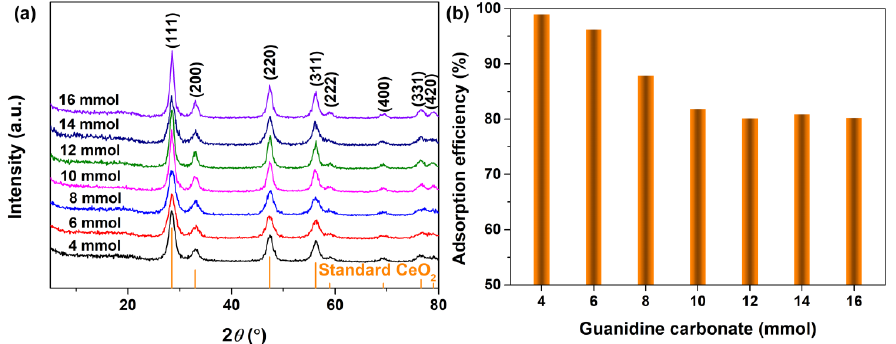
Figure 2. ( a ) XRD patterns of the hydrothermally synthesized CeO 2 samples at 180 °C for 24 h with different addition amounts of guanidine carbonate (4~16 mmol) and 5 mL 30% H 2 O 2 . ( b ) Adsorption histograms of AO7 dye onto the as − obtained corresponding CeO 2 in Figure 2a ([CeO 2 ] = 2.0 g/L; [AO7] = 100 mg/L; V = 100 mL; 200 rpm; Room temperature; No pH preadjustment; t = 60 min).